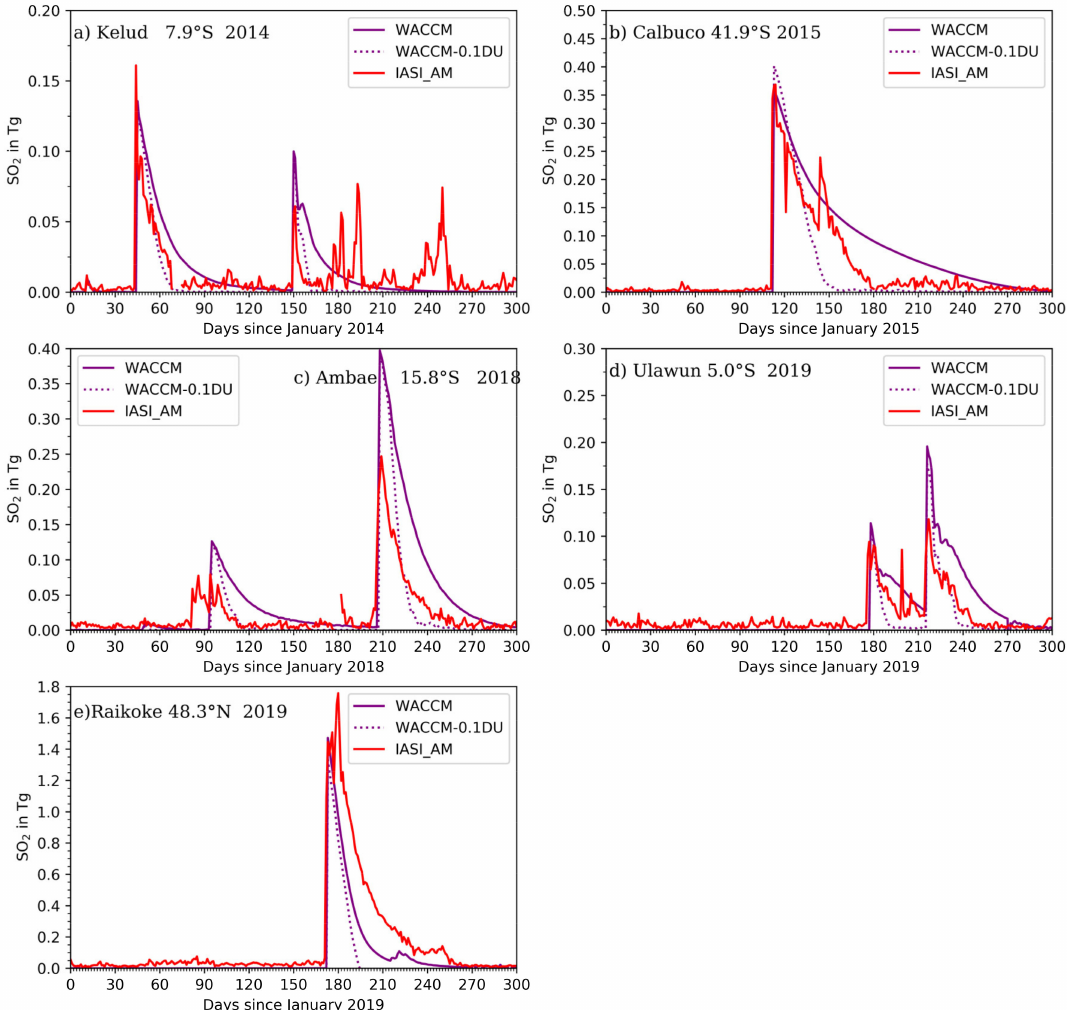
Figure 1. Temporal evolution of the SO 2 total column anomaly (in Tg) averaged over the area of emission, i.e., tropics (20 ◦ S–20 ◦ N) for Kelud, Ambae and Ulawun, SH (0–80 ◦ S) for the mid-latitude Calbuco volcano, NH (0–80 ◦ N) for the mid-latitude Raikoke volcano as observed by IASI (full red lines) and simulated by WACCM-CARMA (full purple line). Model anomaly denotes a volcano-on simulation from which the volcano-off control run has been subtracted. A detection threshold of 0.1 DU (dotted lines) has been applied to the model (see text). Some peaks in the SO 2 column detected by IASI can be attributed to volcanic emissions in the troposphere not necessarily accounted for in the simulation. Furthermore, indicated are the latitudes of each